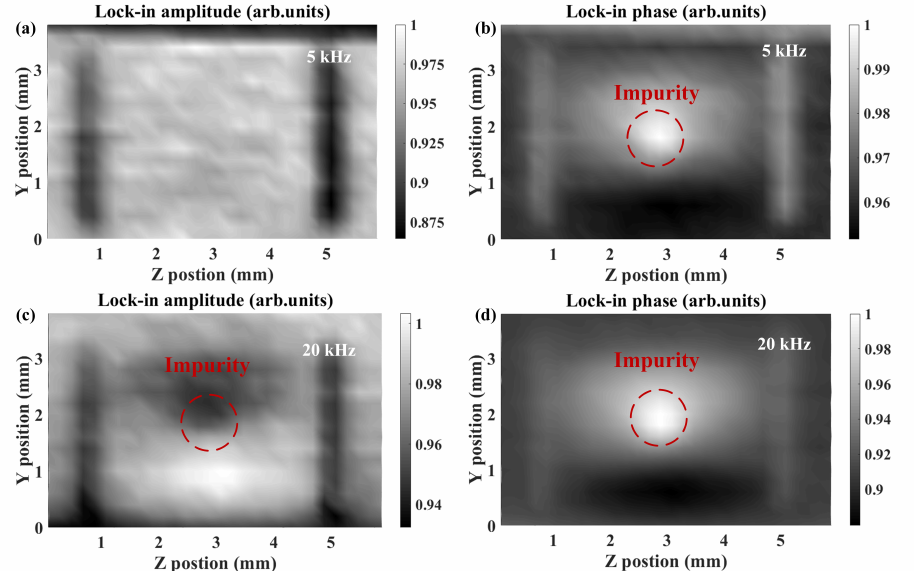
Figure 4. Imaging pictures of solid batteries with the impurity. ( a – d ) are amplitudes and phases of LIA for the battery with an impurity at frequencies of 5kHz and 20kHz.